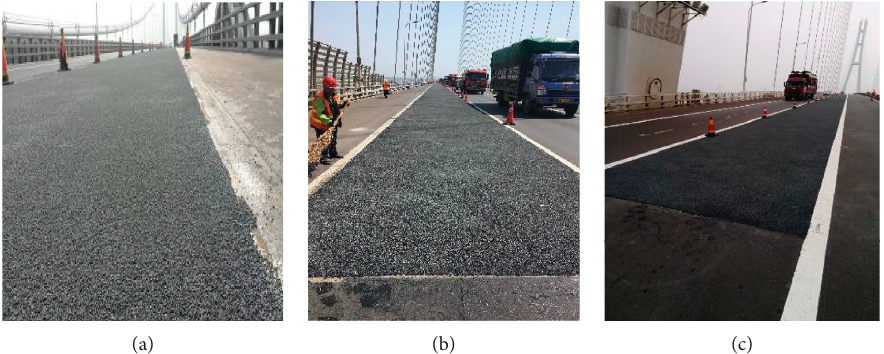
Figure 21: Effects of construction. (a) Zhenjiang–Yangzhou Yangtze River Bridge (2014). (b) The third Nanjing Yangtze River Bridge. (c) Suzhou–Nantong Bridge.